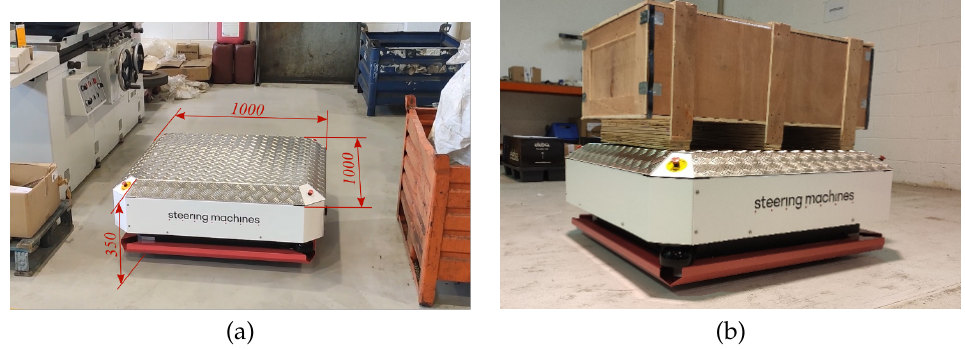
Figure 1. ( a ) Moby-500 general view and dimensions (in millimeters), ( b ) Moby-500 with load.